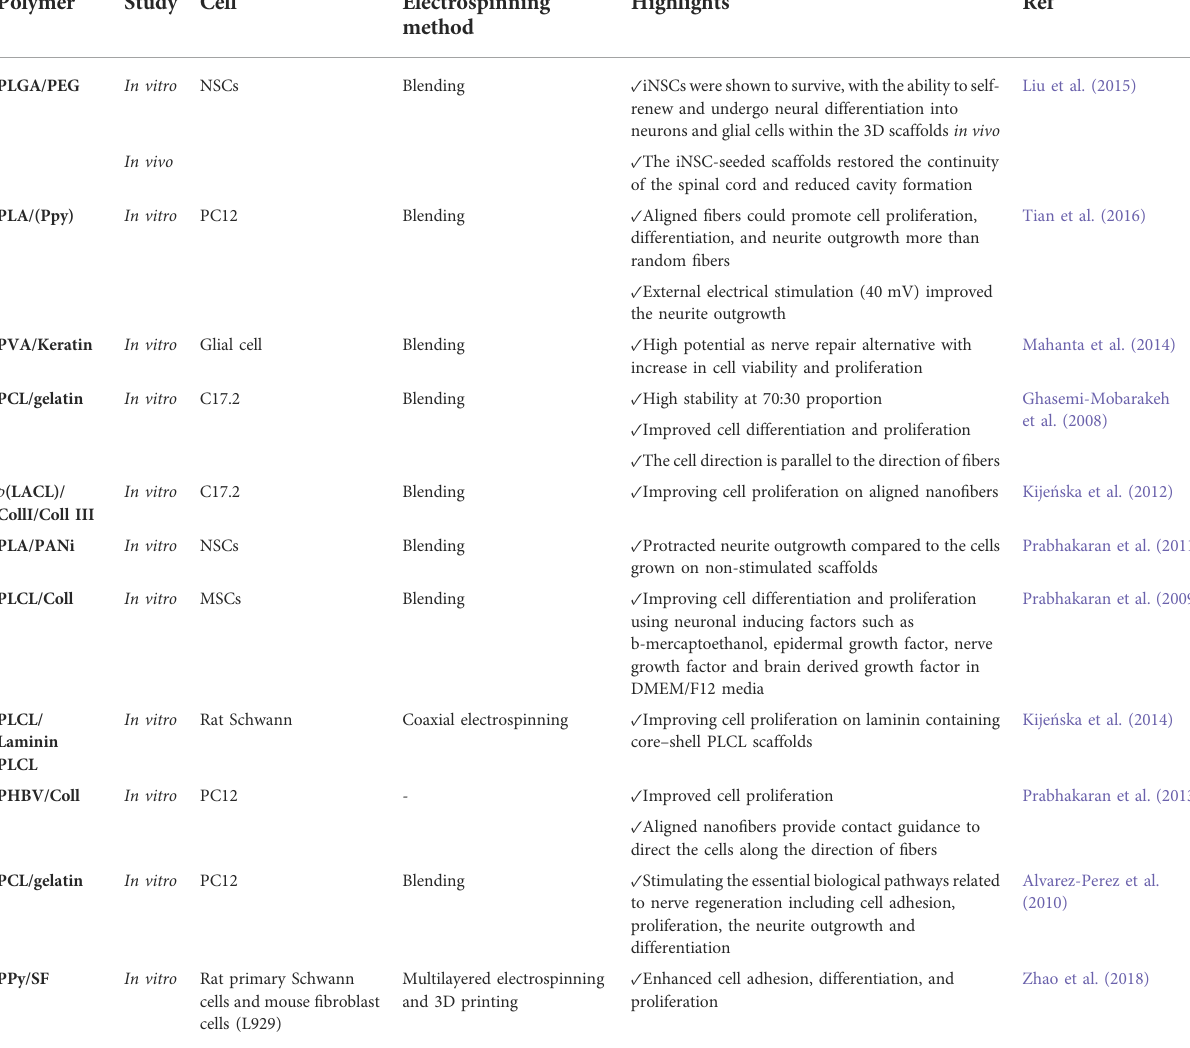
TABLE 8 An overview of electrospun hybrid nano fi ber for nerve regeneration. Polymer Study